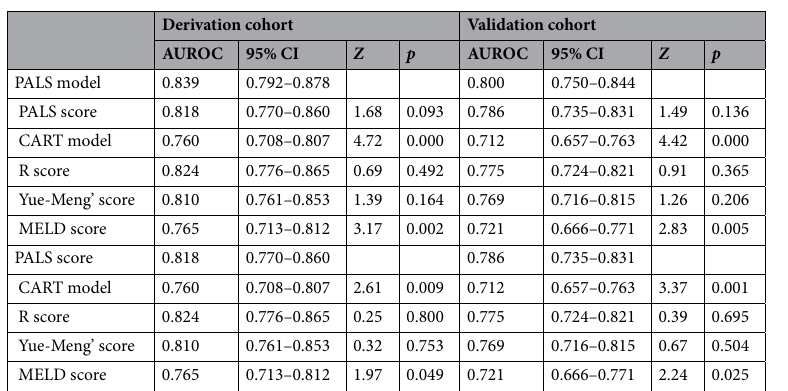
Table 5. Comparison of the predictive values of PALS model, PALS score and other predictors. Area under the ROC curves (AUROCs) for different models were calculated and compared using the Z test (Delong’s method). PALS model logistic regression model of risk predictors for citrate accumulation, PALS score risk score for citrate accumulation, CI Confidence interval, CART model classification and regression tree model, MELD , model for end-stage liver